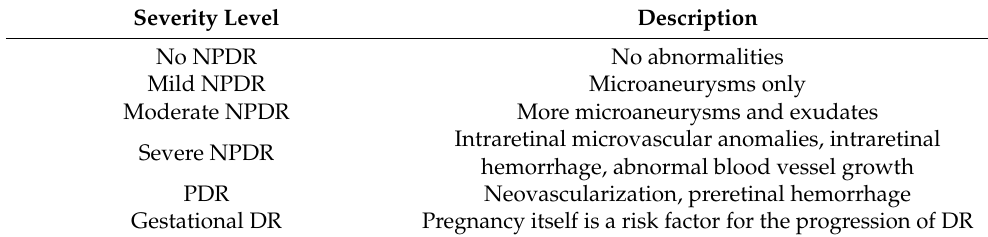
Table 1. Diabetic retinopathy (DR) severity levels